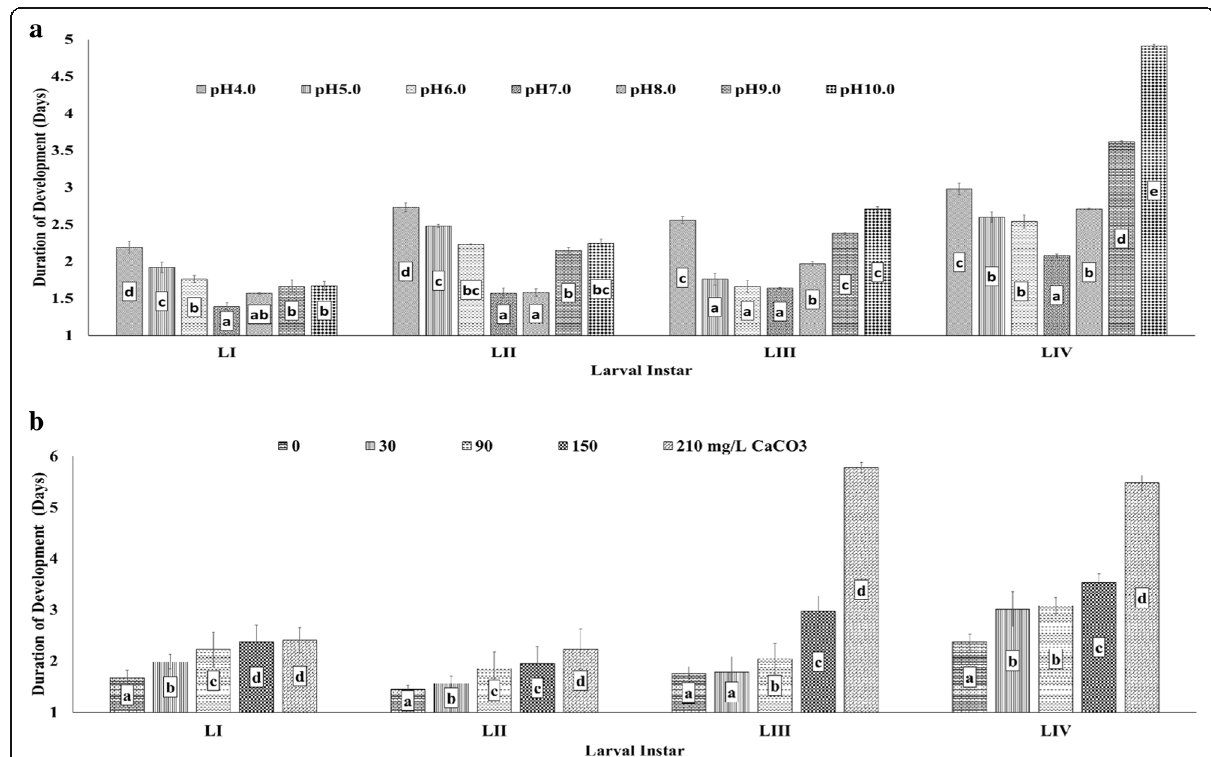
Fig. 1 Bars followed with the same letter are not significantly different at p < 0.05 according to Duncan multiple range test following ANOVA and represent mean (± SD). a Effects of water pH on developmental times of larval instars (I – IV) of Culex quinquefasciatus. b Effects of water hardness